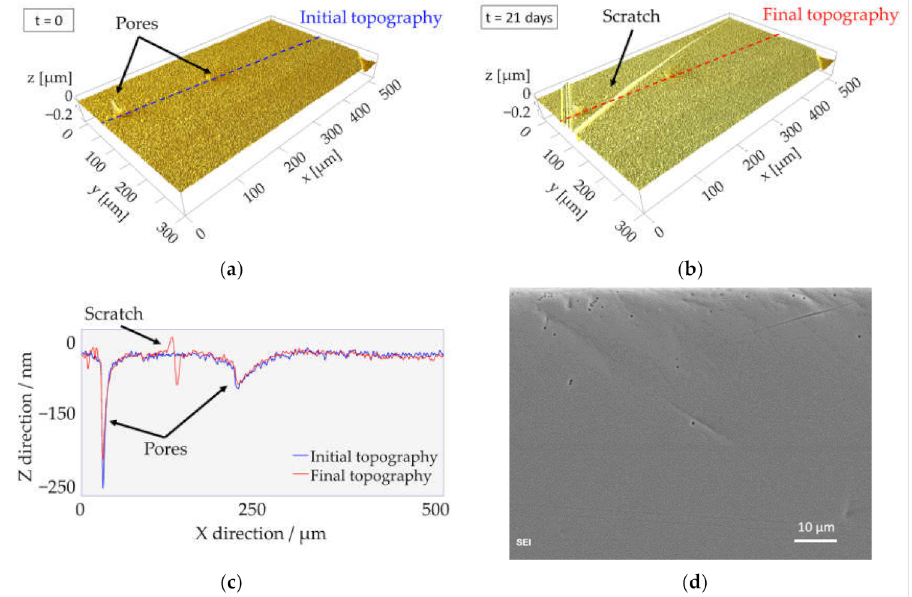
Figure 2. Topography analyses for the cast material: ( a ) surface area before corrosion (t = 0) obtained with VSI (vertical scanning interferometry); ( b ) surface post-corrosion (t = 21 days) obtained with VSI; ( c ) the topography line-profiles of the initial (blue curve) and final topography (red curve). The position of the profile is identical and is shown in ( a , b ) as a dashed line; ( d ) SEM micrograph of an area near the edge of the